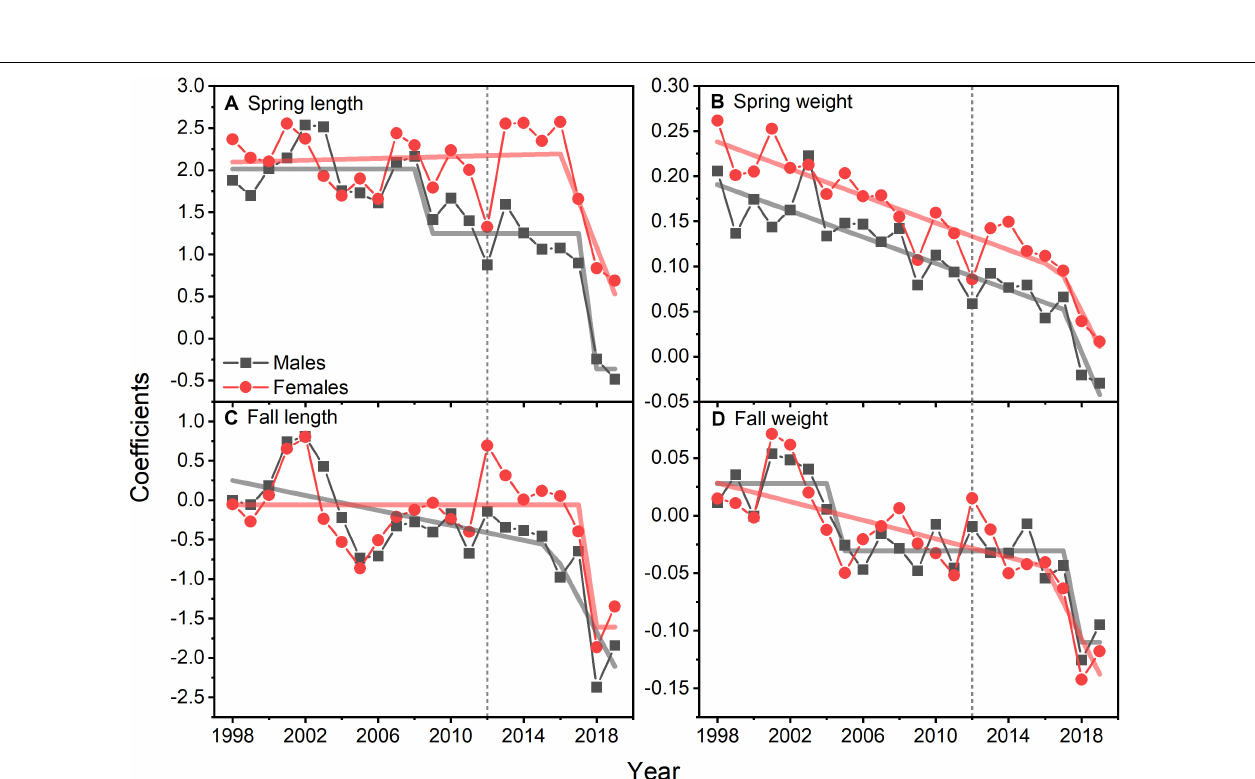
FIGURE 8 | GLM model coefficients of length (A) and weight (B) for males and females of 15 species of fish during spring. GLM model coefficients of length (C) and weight (D) for males and females of 15 species of fish during fall. Lines are either STARS or segmented regression model fits; vertical dotted line marks 2012.